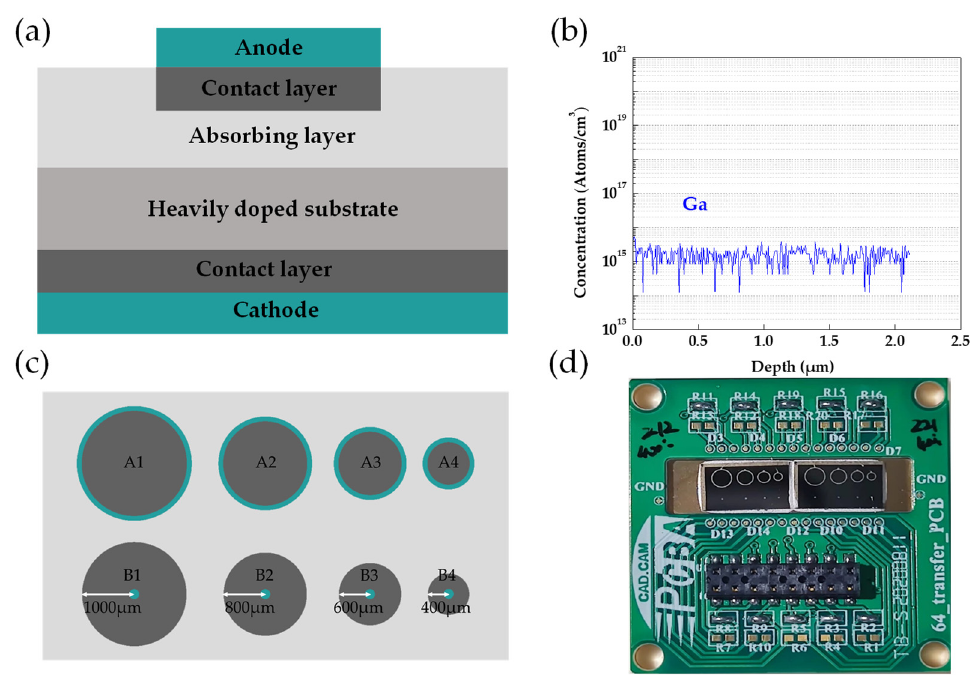
Figure 1. ( a ) Vertical structure of the Ge:Ga THz photoconductive detectors. ( b ) The SIMS result of the Ge epitaxial layer. ( c ) Top schematic of the detectors. ( d ) A photo of the detectors after packaging. The absorption layer was fabricated by growing a 100 µ m-thick Ge:Ga epitaxial layer on a highly conductive Ge substrate, with a Ga concentration of 1 × 10 15 cm 3